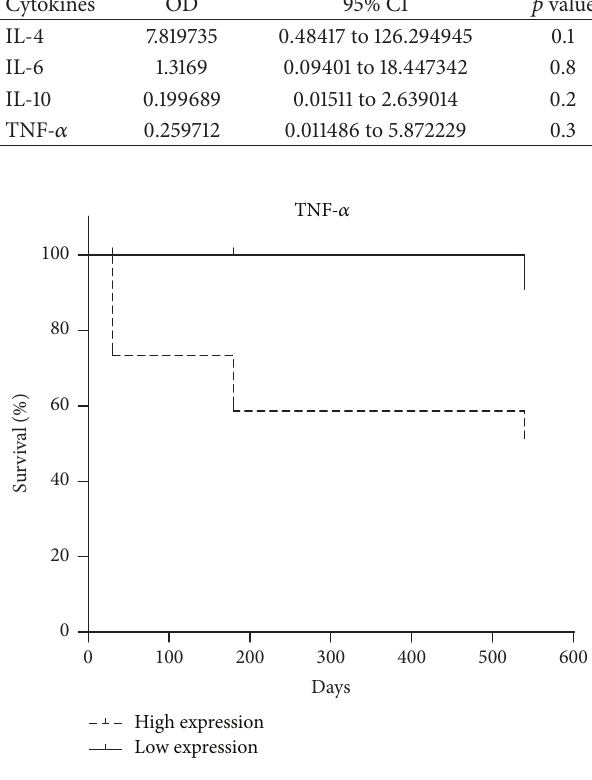
Figure 7: Survival curve of TNF- 𝛼 . Tumors of female dogs with high expression (dotted line) of TNF- 𝛼 had higher chance of death compared with animals with low expression (black line). 𝑝 = 0.01 .